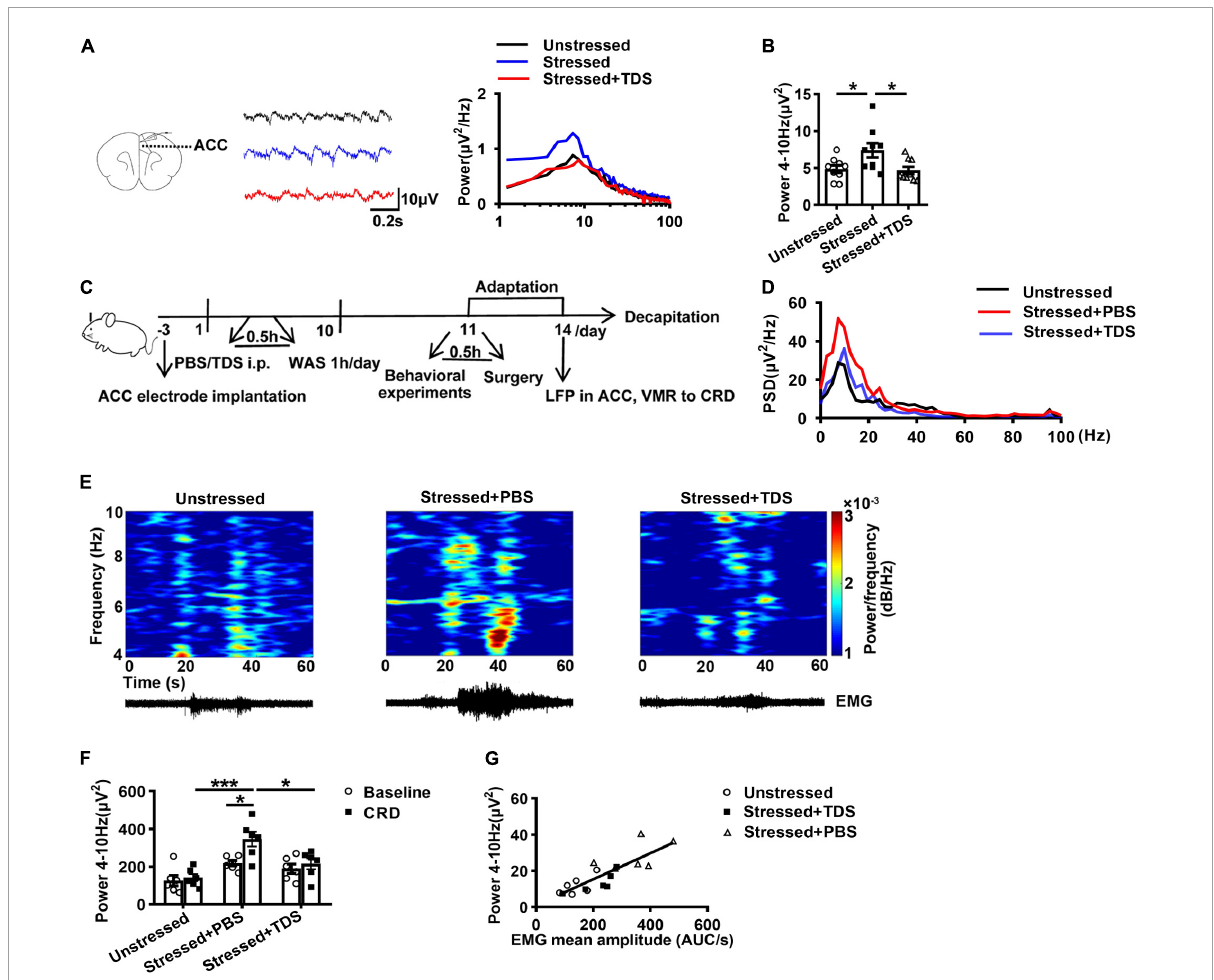
FIGURE4 TDS reduced the enhancement of theta band (4–10 Hz) power in ACC of stressed rats. (A) Sample traces (left) and power spectra (right) of oscillations in ACC slices in the absence or presence of TDS. (B) Summary of the data showing the effect of TDS on theta oscillations in ACC of stressed rats (Unstressed: n = 9 from six rats, Stressed: n = 9 from five rats, Stressed + TDS: n = 9 from five rats). TDS reduced the enhancement of theta band power in ACC of stressed rats in vivo (Unstressed, Stressed + PBS, and Stressed + TDS: n = 6, respectively). (C) Experimental design. (D) Mean power spectral density (PSD) plots during 20s-CRD treatment in ACC of unstressed (black line), stressed + PBS (red line), and stressed + TDS (blue line) rats. (E) Time-frequency diagrams of the power of theta oscillations in ACC and corresponding EMG. (F) The integral power of theta oscillations during pre-CRD (Baseline) and 20s-CRD. (G) Correlation between theta oscillation power in ACC during 20s-CRD and the EMG of visceromotor response, based on combined data points obtained in the unstressed (circle), stressed + PBS (triangle) and stressed + TDS (square) rats, R 2 = 0.6908, p < 0.0001. * p < 0.05, ** p < 0.01, *** p < 0.001. Data are presented as means ± SEM.